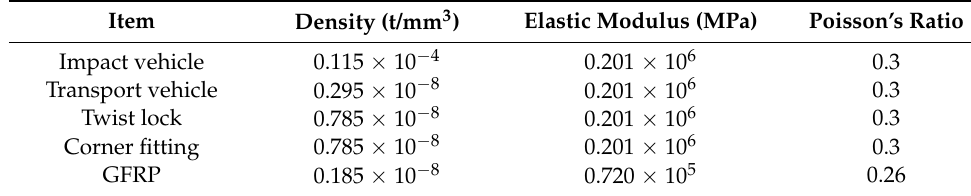
Table 2. More structural material properties.